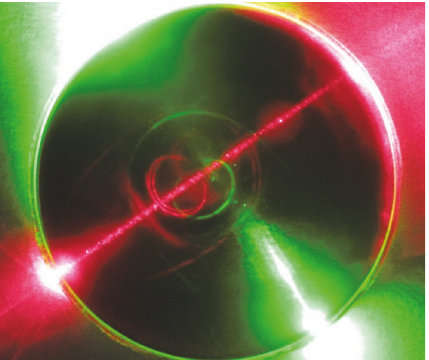
Figure 8: Two crossed laser beams (red and green) in a circular Ferrocell with a magnetic ring behind it. There is no polarizer in this setup. We can observe the ferrofluid particles scattering light forming curved structures at the center of the picture, which resembles some parts of the magnetic